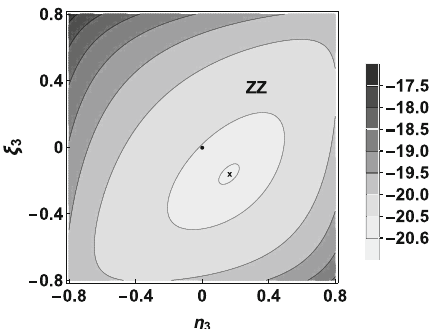
Fig. 5 Thelogofaveragelikelihood,log [ L ( V f , { O }; η 3 ,ξ 3 ) ] asafunc- tion of beam polarization is shown for the Z Z process at GeV and L = 100 fb − 1 . The dot at the center is the (0 , 0) point, while cross mark at P ZZ = ( + 0 . 16 , − 0 . 16 ) is the minimum likelihood point and hence the best choice of beam polarizations for Z Z process